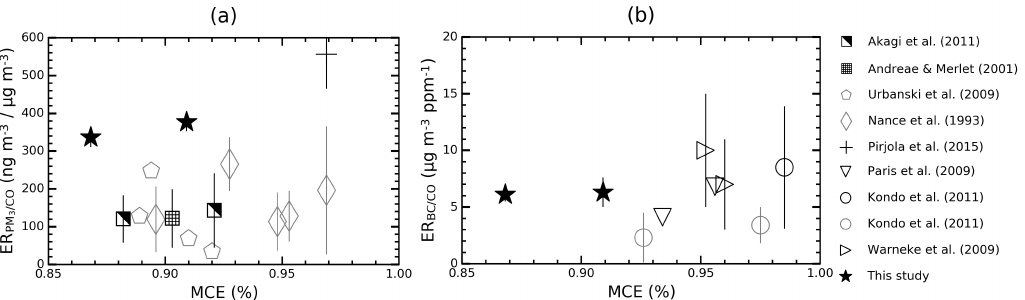
values of 18 and 34 % (MCE = 0.85–0.75) related to